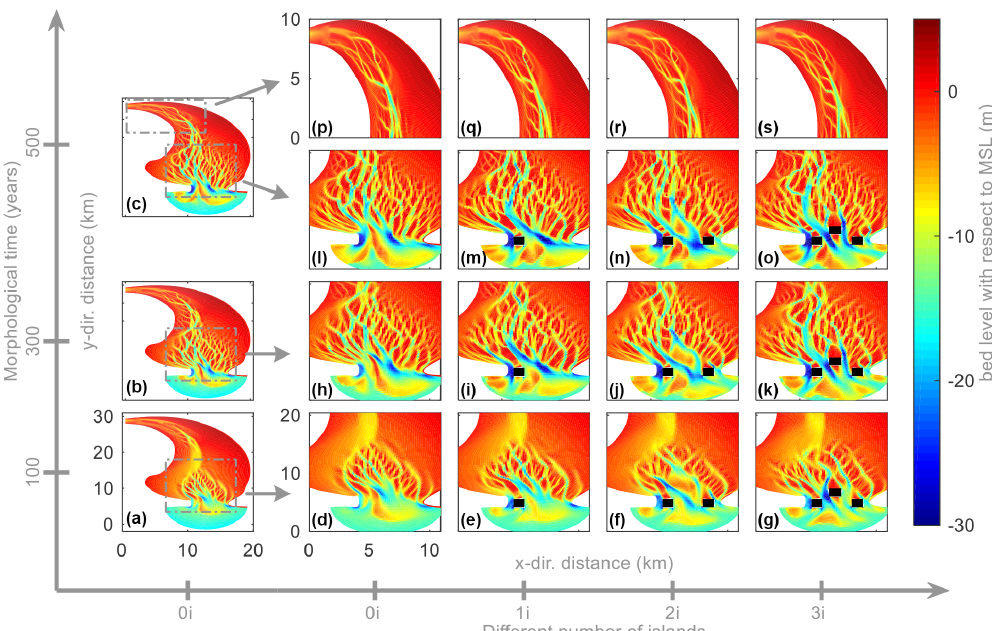
Figure 4. Morphological evolution after 100 years (a, d–g) , 300 years (b, h–k) and 500 years (c, l–s) of a basin without an island (“0i”), basin with one island (“1i”), basin with two islands (“2i”) and basin with three islands (“3i”), respectively. Here, we only plot part of the model domain, where the bed-level changes. The solid black rectangles in panels (m) , (n) , (o) , (i) , (j) , (k) , (e) , (f) and (g) represent mouth